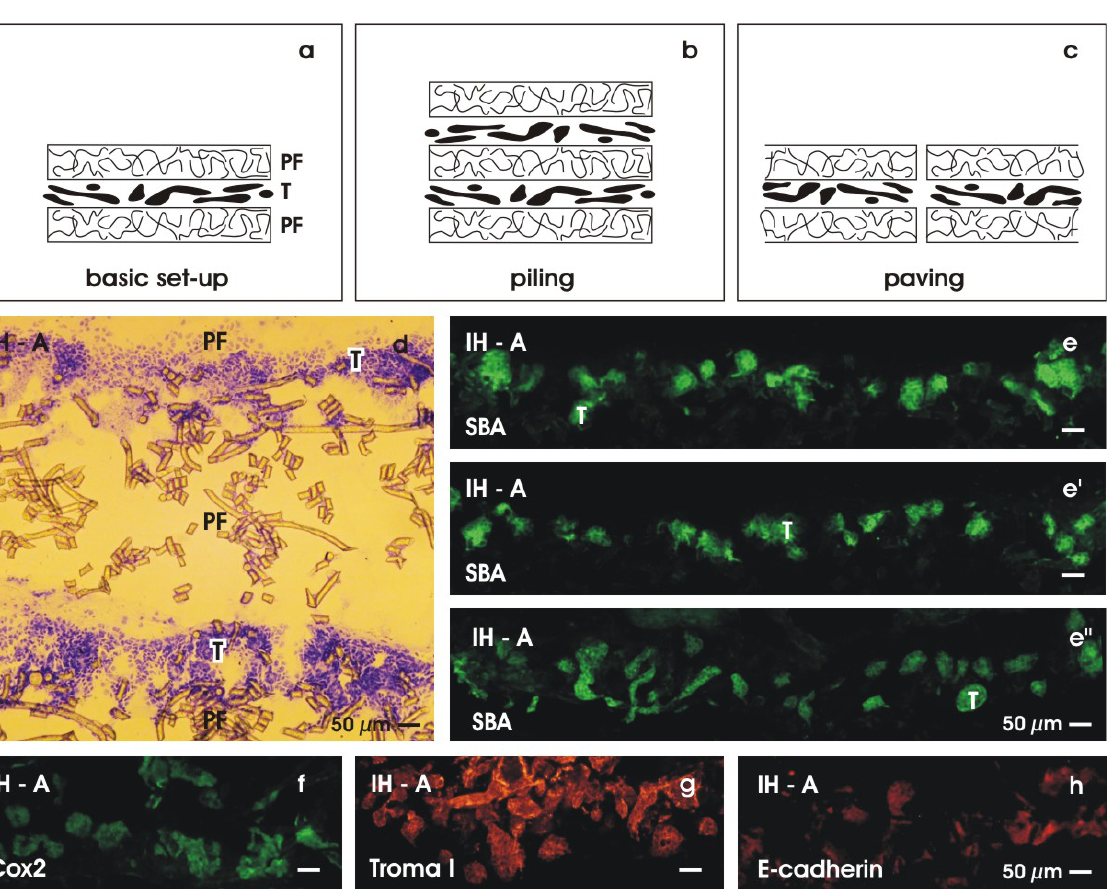
Figure 10. Guiding the spatial extension of generated tubules. (a) An artificial interstitium is created by mounting generated tubules (T) between layers of polyester fleece (PF). (b) Layers of tissue can be increased by piling. (c) The basic sandwich set-up configuration can also be used to extend the area of growth by paving. (d) Toluidin blue stained cryosection demonstrates two rows of tubules (T) between polyester fibers (PF) in a piled specimens. (e, e’, e’’) SBA-label of tubules generated in piled specimens. Immuno-label for (f) cyclooxygenase 2 (Cox2), (g) Troma I, (h)